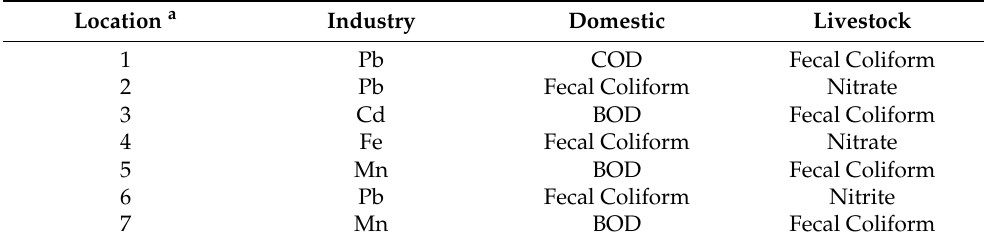
Table 1. Summary of the selected key parameters. Location a